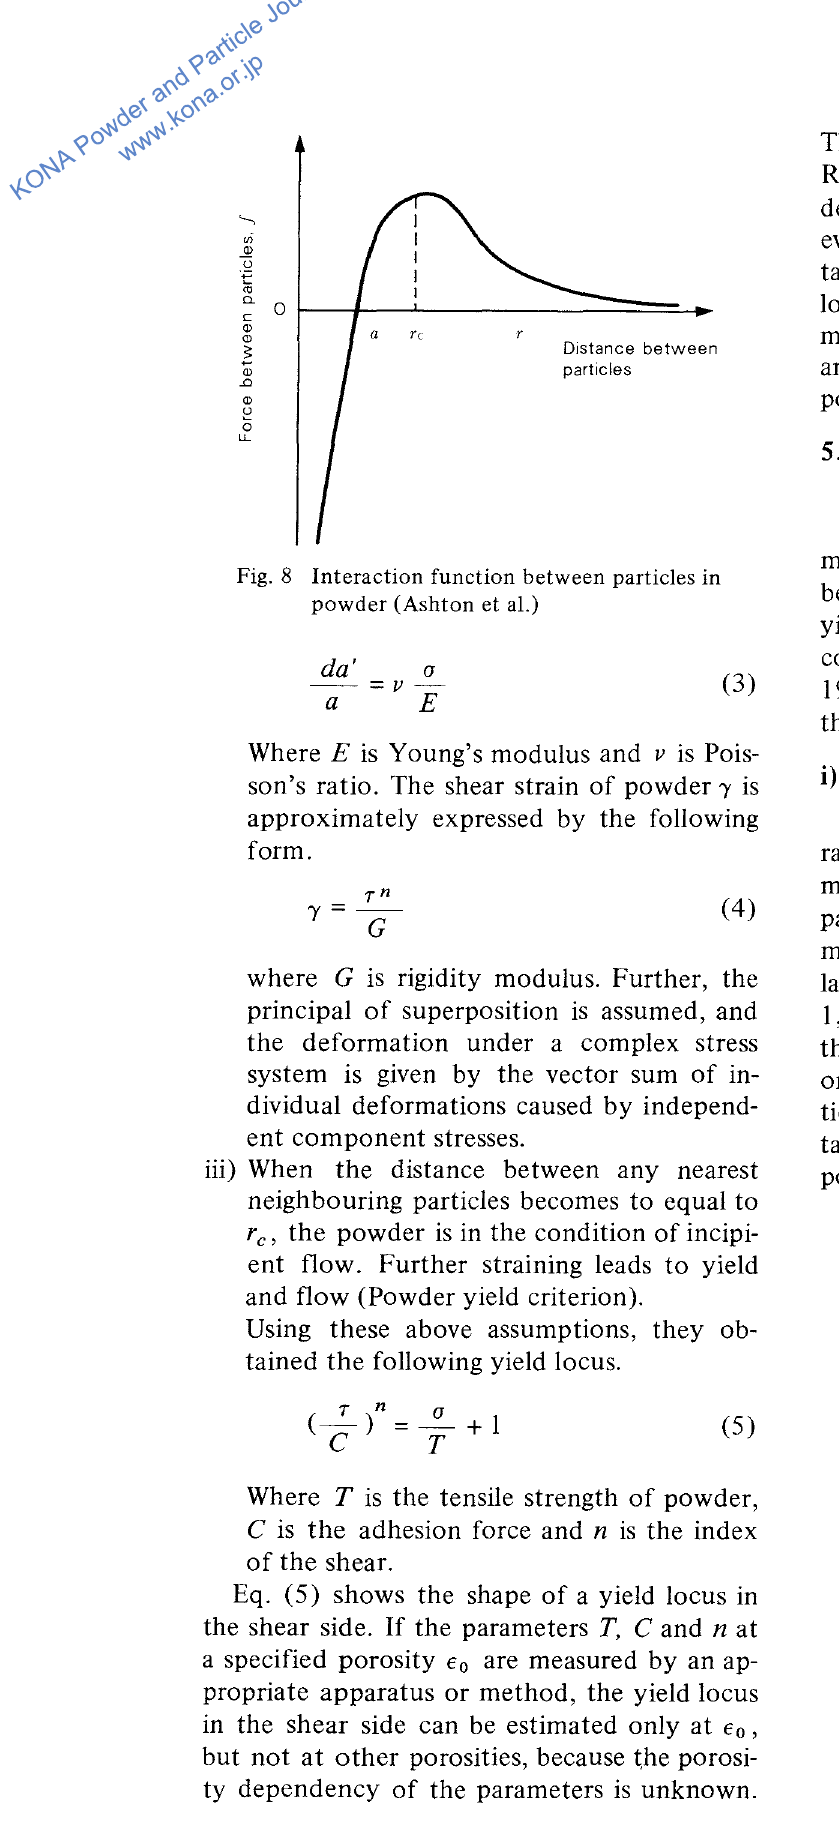
Fig. 9 Particle arrangement described by statistical model (Makino et